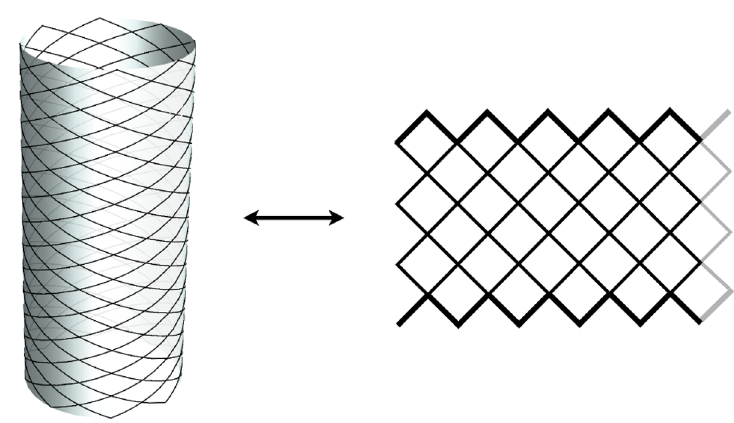
Figure 3 . In the closed channel, there are 2 N sites in the horizontal direction with periodic boundary conditions, and 2 M + 1 sites in the vertical direction with free boundary